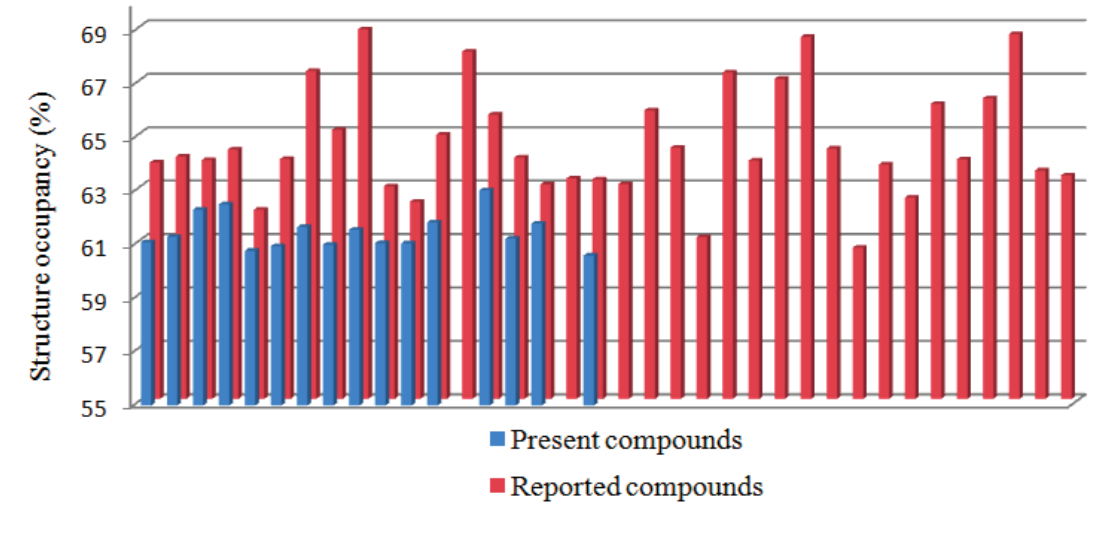
Figure 2. Structural occupancy comparison of the present and reported